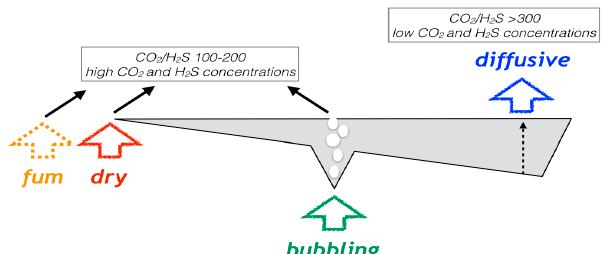
Figure 8. Conceptual model of CO 2 / H 2 S ratios for the Fangaia basin on 6 June 2017 and the role of bubbling versus diffuse degassing. “Fum” indicates the Bocca Nuova and Bocca Grande fumarole degassing, 200 m off Fangaia; “dry” indicates the degassing area in the dry sector of Fangaia basin, however with lower absolute gas concentrations with respect to the strongest bubbling areas.